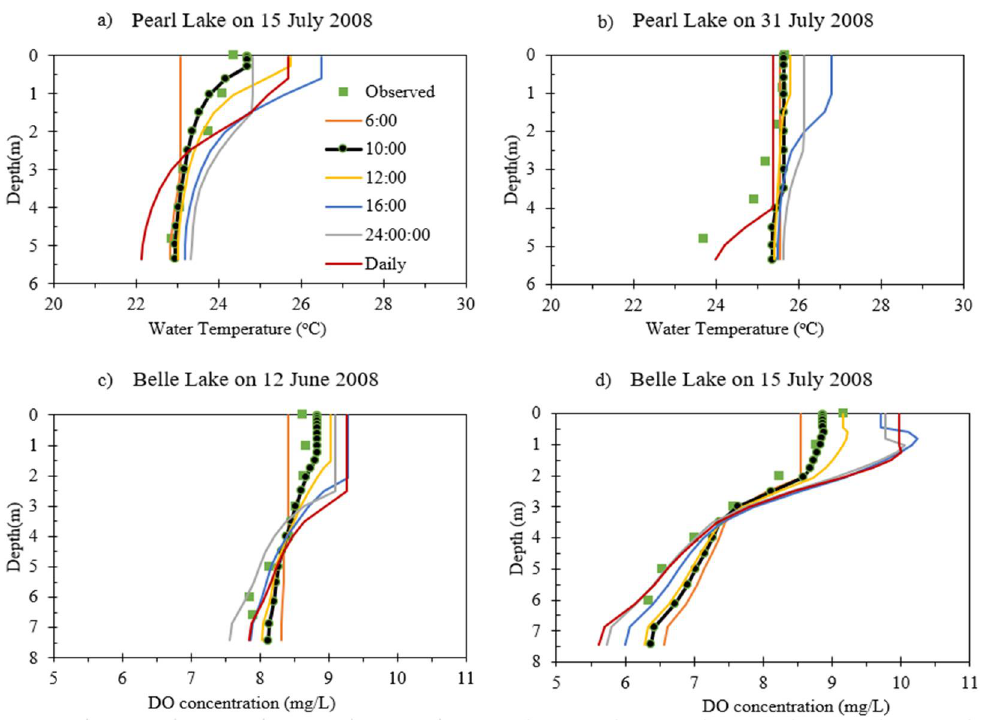
Figure 5. Simulated water temperature profiles in Pearl Lake and DO profiles in Belle Lake at five different hours comparing with observed (green squares) and simulated daily profiles.